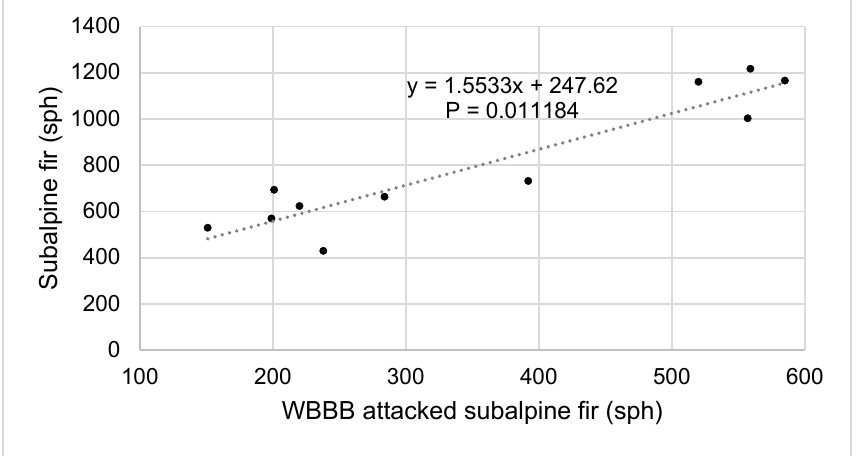
Figure 7. Relationship of subalpine fir stems per hectare (sph) at establishment and total subalpine fir killed by D. confusus (sph) at the final assessment, for 11 plots in southern interior B.C.. The average dbh of live subalpine fir (all plots) was greater at the final assessment (Avg. ± S.E. = 26.3 ± 1.6 cm) than at the plot establishment (Avg. ± S.E. = 23.7 ± 1.1 cm) (t-